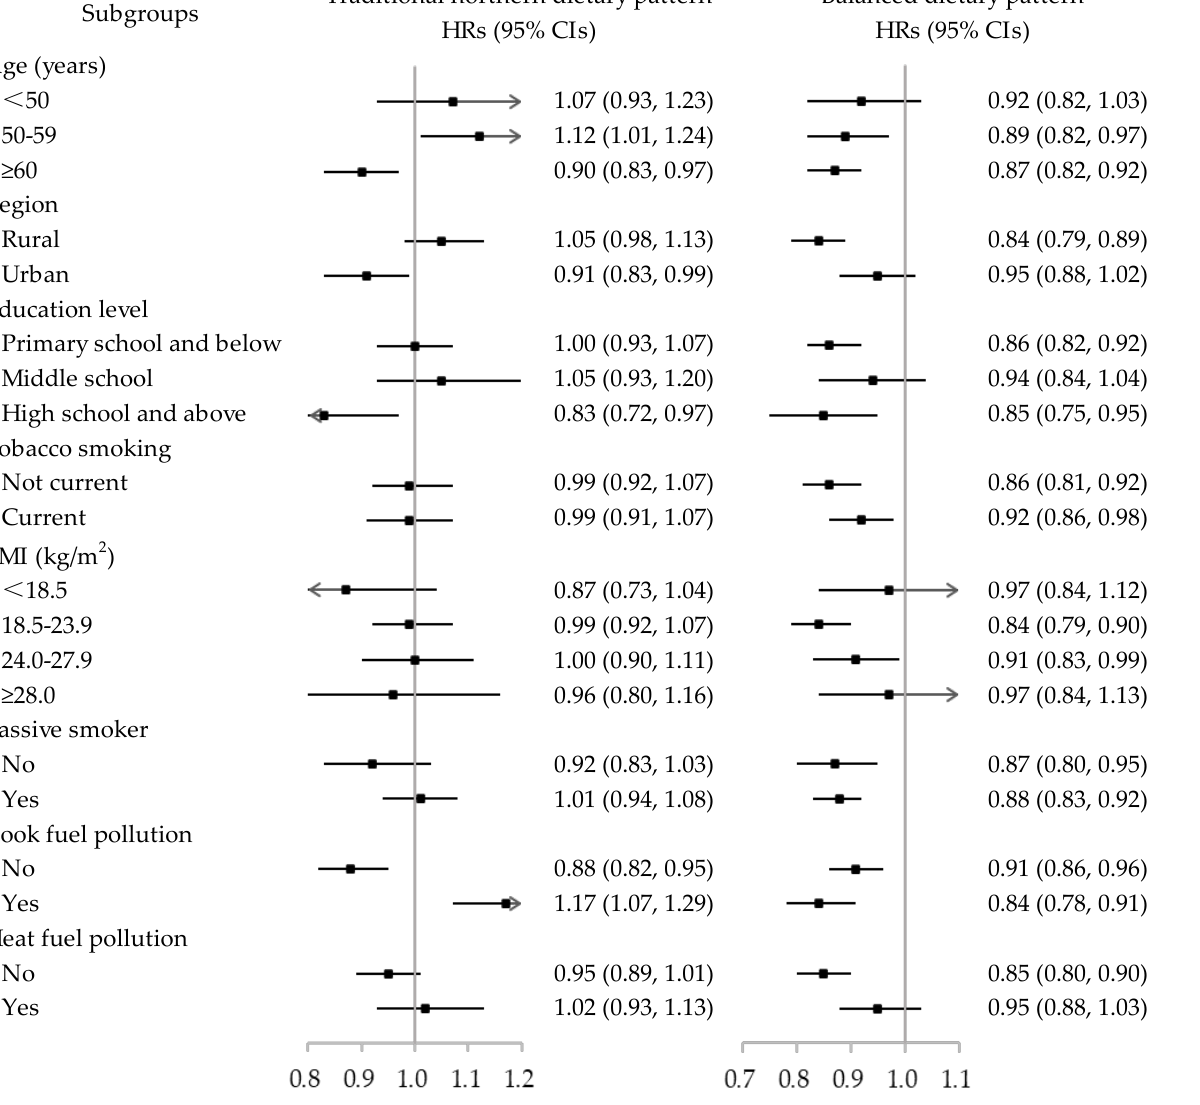
Figure 1. Subgroup analyses of the association between two dietary patterns and risk of COPD. Note: HRs (95% CIs) per standard deviation change of each dietary pattern score for Model 3 were presented. Adjusted variables included sex, education level, marital status, household income, tobacco smoking, alcohol consumption, nutritional supplement, BMI, physical activity, daily energy intake, passive smoking, cook fuel pollution, and heat fuel pollution, if appropriate. p values for interaction were <6.25 × 10 − 3 for region ( p < 0.001) in the traditional northern dietary pattern and tobacco smoking ( p < 0.001) and BMI ( p = 0.006) in the balanced dietary pattern. HR: hazard ratio; CI: confidence interval; CNY: unit of Chinese money Yuan; BMI: body mass